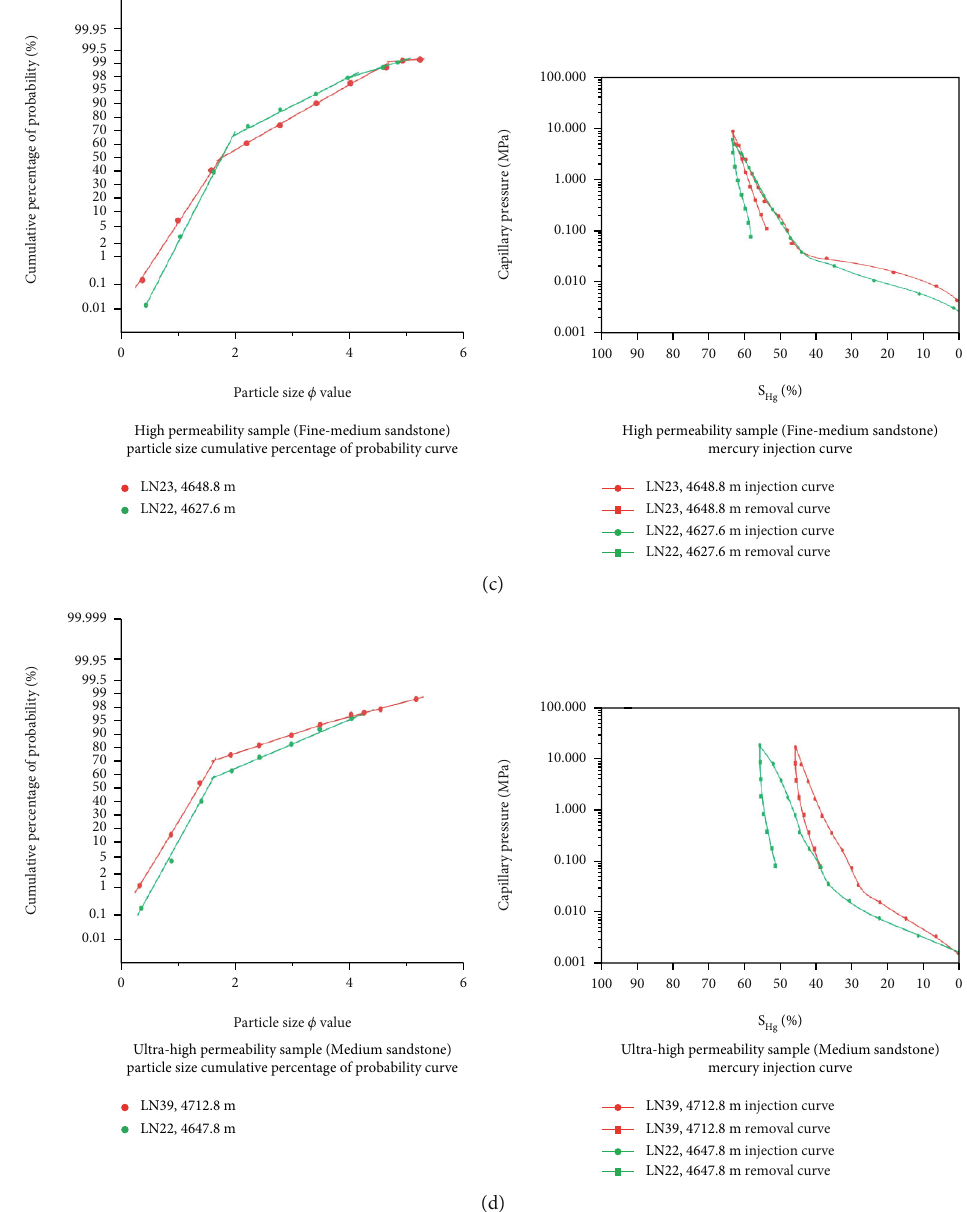
Figure 7: Cumulative probability curve and mercury injection curve of di ff erent core samples from the TIII reservoir in Sangtamu Oil fi